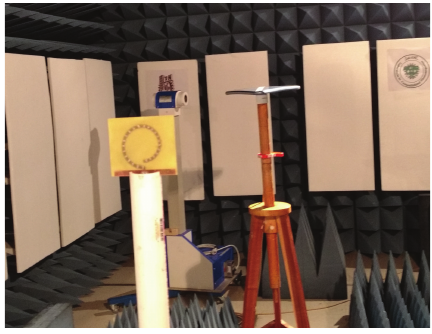
Figure 12: Magnitude versus frequency (measurement).